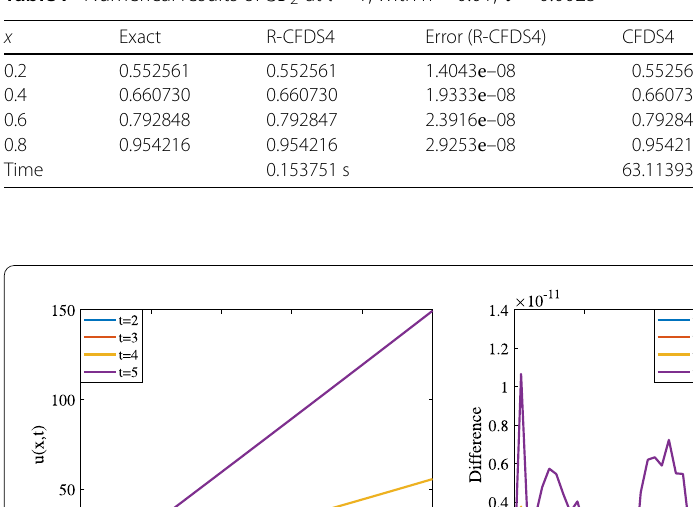
Table 7 Numerical results of SP 2 at t = 1, with h = 0.01, τ = 0.0025